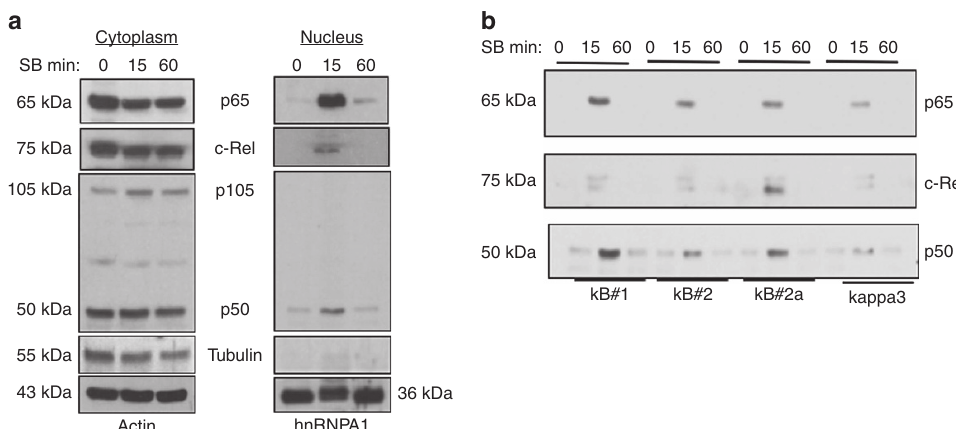
Figure 5 | GSK3 inhibition leads to NF-kB activation and its binding to the TNF promoter in human NK cells. ( a ) Human NK cells were treated with the GSK3 inhibitor SB for the indicated times, cytoplasmic and nuclear lysates were prepared, and analysed by Western blotting using indicated antibodies. Actin and hnRNPA1 were used as internal loading controls for cytoplasmic and nuclear extracts. Tubulin was used as a control to examine the purity of nuclear extracts. Experimental control in which NK cells were treated with DMSO, the vehicle used to dissolve SB is shown in Supplementary Fig. 6. ( b ) Expanded NK cells were treated with SB for the indicated times. Nuclear extracts were prepared and analysed by Oligonucleotide pull-down assay to examine NF-kB binding to the TNF promoter. Data presented are representative of two independent studies. Experiment is performed three times.